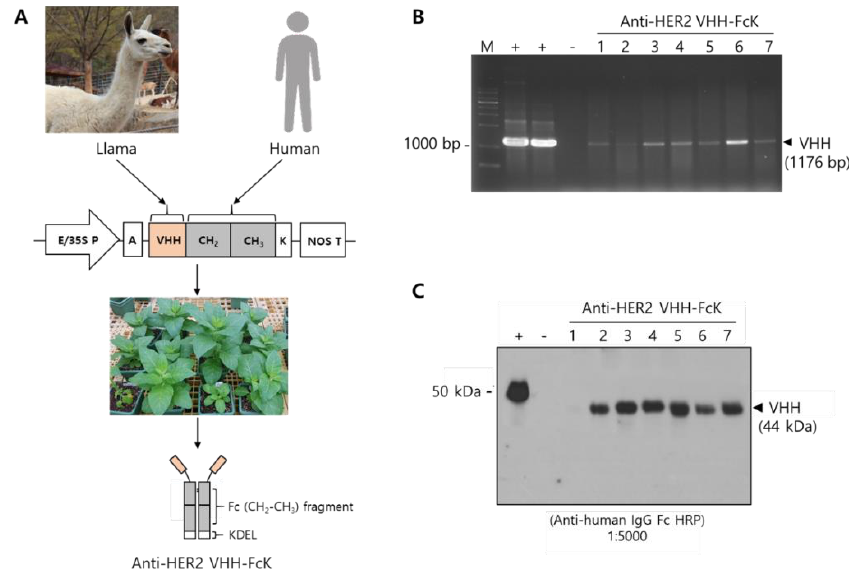
Figure 1. Schematic illustration of production of the plant-derived anti-HER2 VHH-FcK antibody. ( A ) Construction of plant expression for vector VHH camelid human Fc fusion antibody. In vitro transgenic tobacco plants were generated to express anti-HER2 VHH-FcK using Agrobacterium -mediated transformation. E / 35S P and NOS T represent promoter and terminator, respectively. A: Alfalfa mosaic virus (AMV) leader sequence; K: KDEL (ER retention signal) sequence. ( B ) PCR analysis to confirm the insertion of the transgene encoding VHH-CH 2 -CH 3 antibody. ( C ) Western blot analysis to confirm anti-HER2 VHH-FcK protein expression. + : positive control, -: negative control.